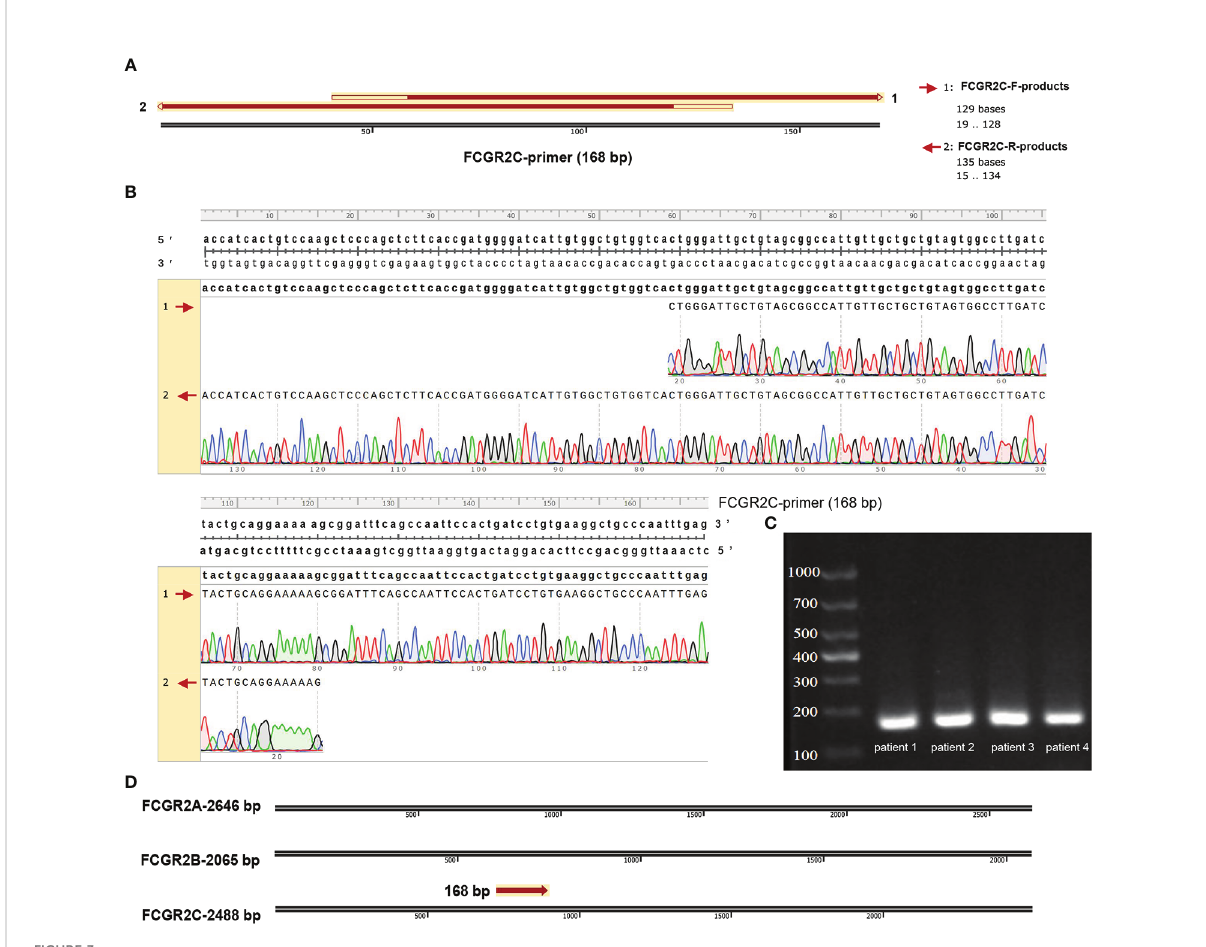
FIGURE 3 Validation of the qRT-PCR products of FCGR2C. (A) Matching the forward and reverse strand product plots with the primer sequences speci fi c to FCGR2C. (B) Details of the complementary base pairing of the forward and reverse strand products with the FCGR2C primer sequence. (C) Agarose electrophoresis plot of qRT-PCR ampli fi cation products of FCGR2C. (D) The 168 base sequence is speci fi c to FCGR2C. First-generation sequencing is a double-end sequencing of the product based on the forward and reverse strand sequences of the primer. The forward strand sequencing results of the products are indicated by 1. The reverse strand sequencing results of the products are indicated by 2. The primers of FCGR2C were designed with a length of 168 bp. The agarose electropherogram showed only one band consistent with the primer sequence ’ s size, indicating the primer ’ s speci fi city. In this study, we performed generation sequencing and agarose electrophoresis of qRT-PCR products from septic patients. Some of the patients ’ results are shown in the pictures. The sequencing results of the forward and reverse sequences of qRT-PCR products and the sequence fi les after double-end splicing are shown in Table